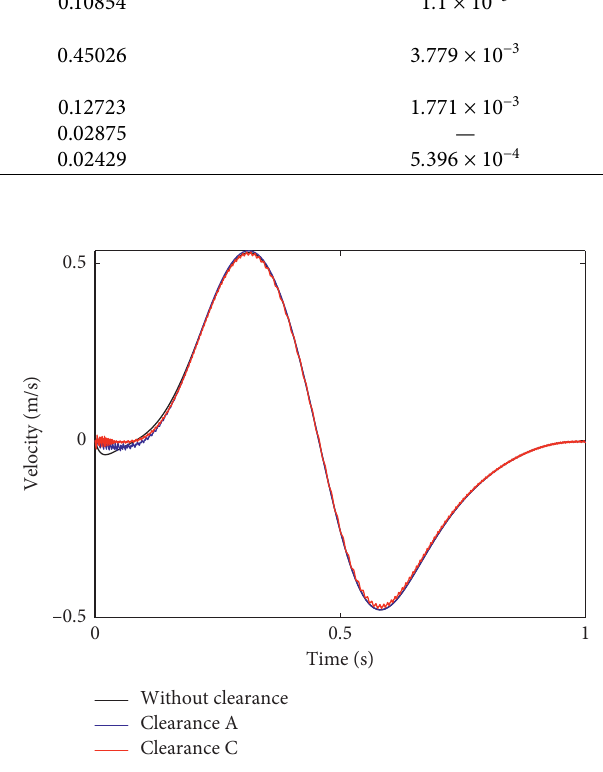
Figure 5: Velocity of the slider under different clearance positions.